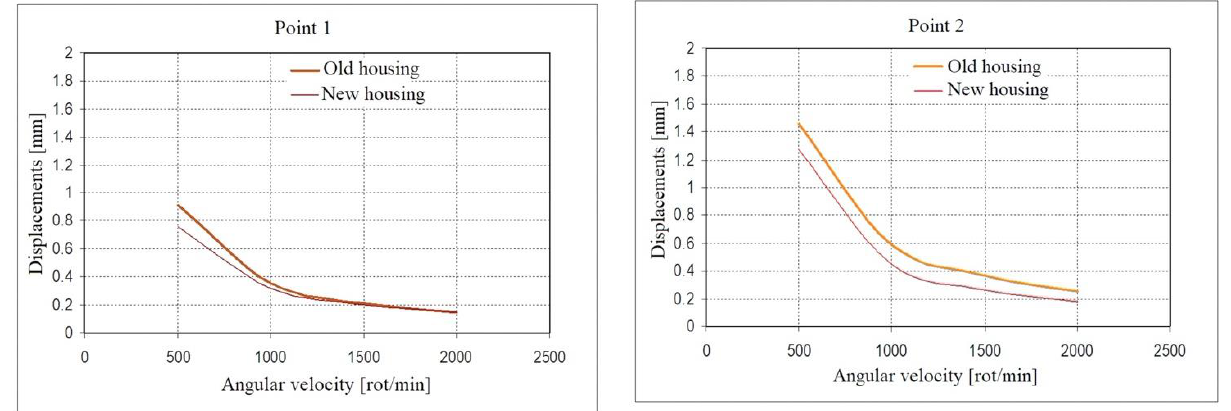
Figure 26. The velocities determined at points 5 and 6 of the two adder boxes (old and new version).